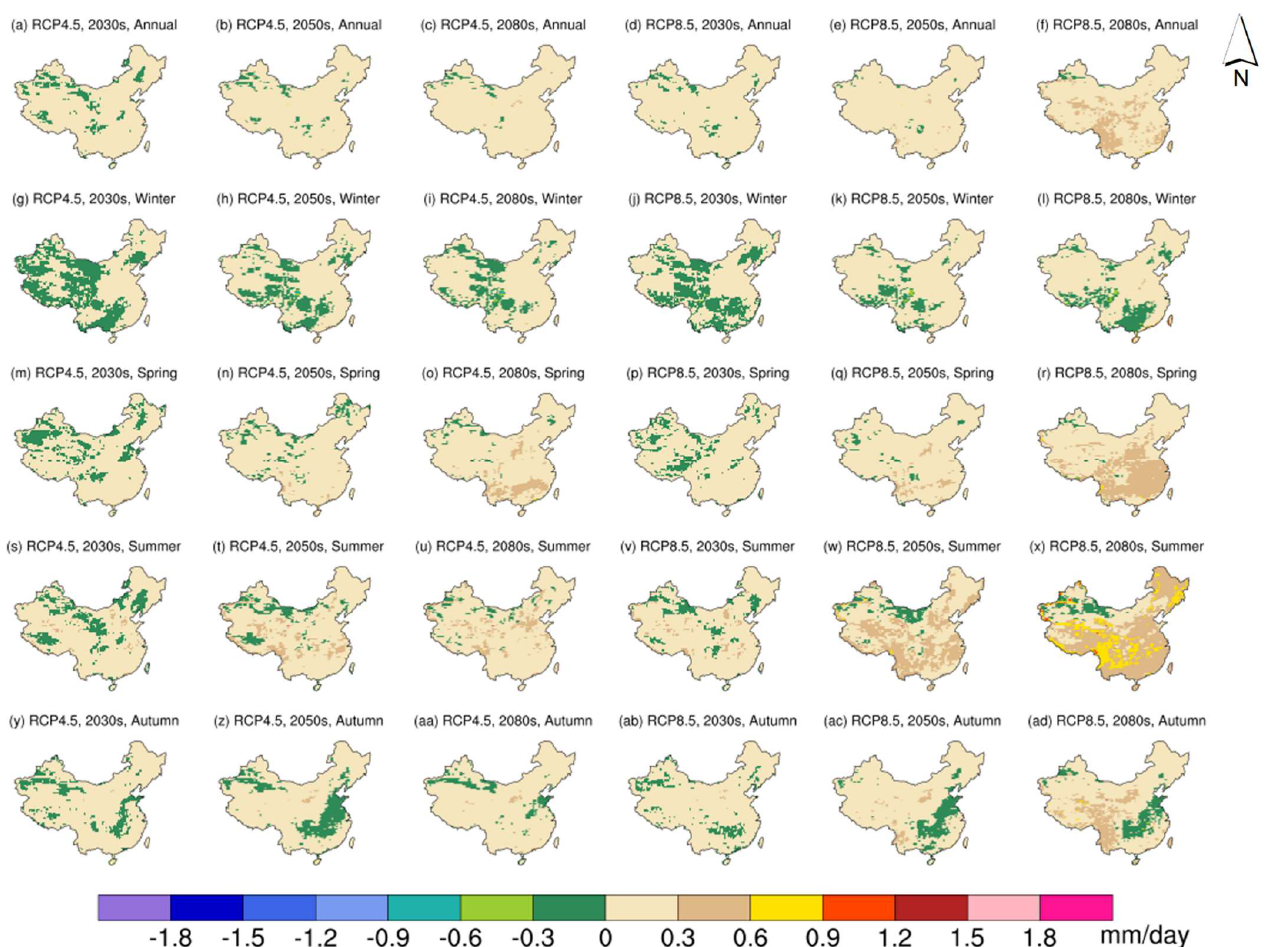
Figure 9. Projected changes in evapotranspiration over China.